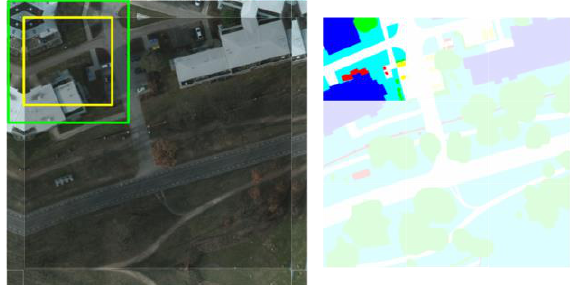
Figure 8. Overlap tile scheme for full image